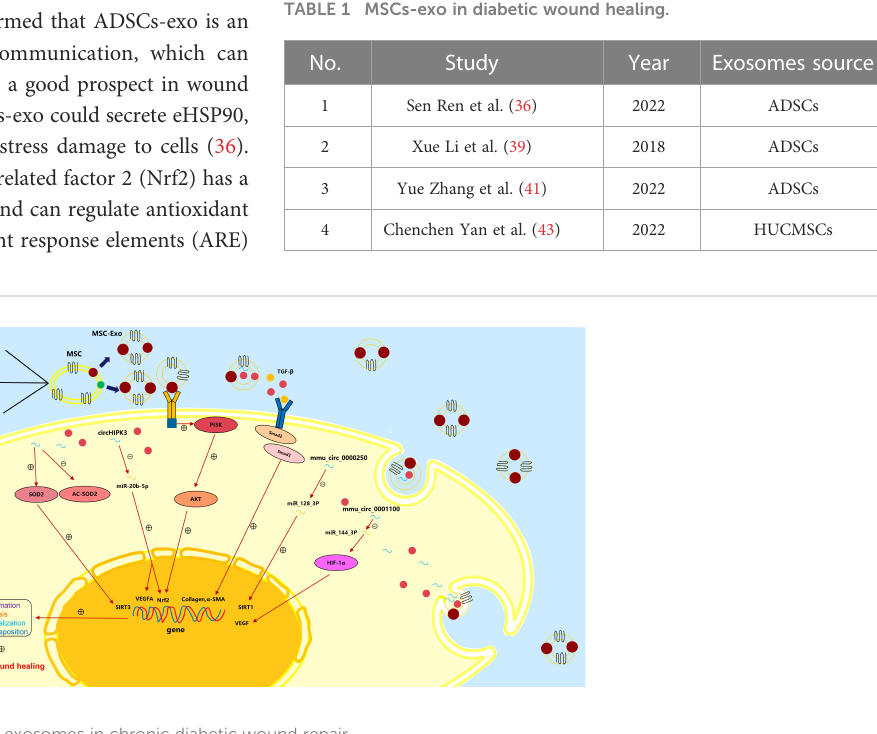
TABLE 1 MSCs-exo in diabetic wound